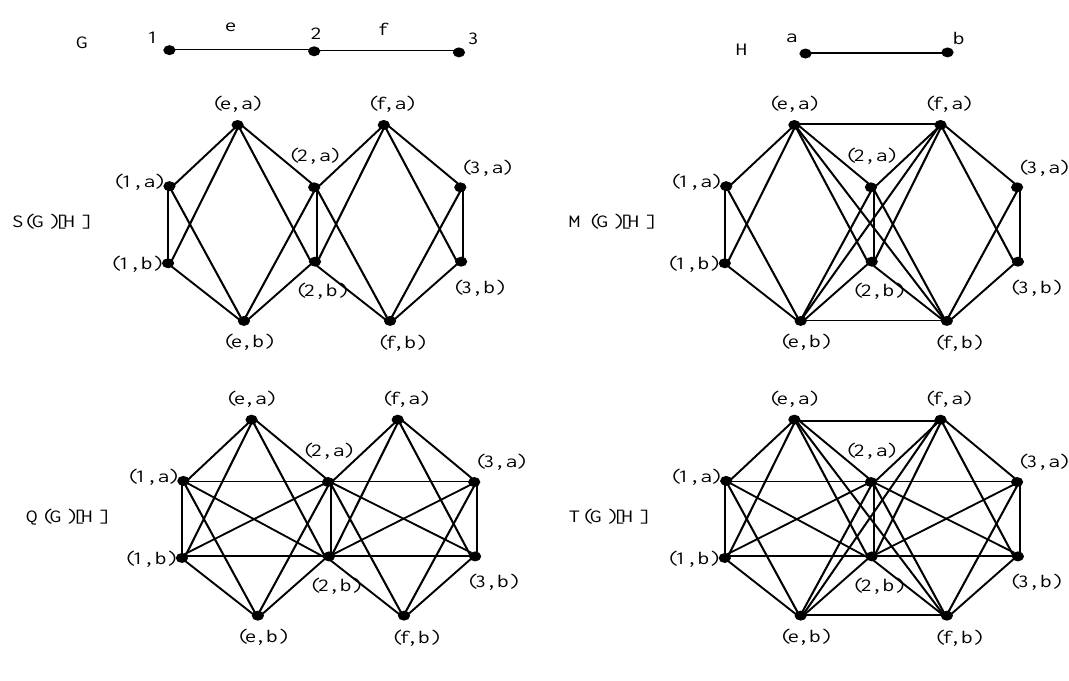
Fig. 4 The graphs G , H , S ( G )[ H ] , Q ( G )[ H ] , M ( G )[ H ] and T ( G )[ H